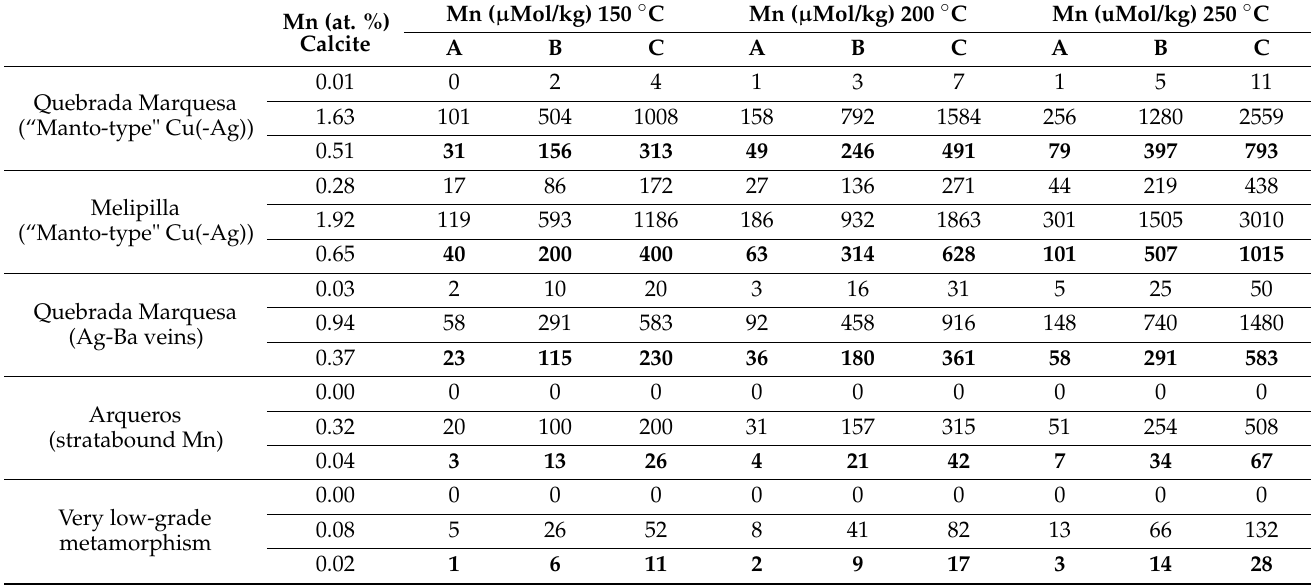
Table 3. Estimates of the Mn content of hydrothermal/metamorphic fluids from the studied areas according to the concentration of Mn in calcites precipitated (minimum, maximum, and average Mn content), the distribution coefficient of [46], and different possible values of Ca in the hydrothermal